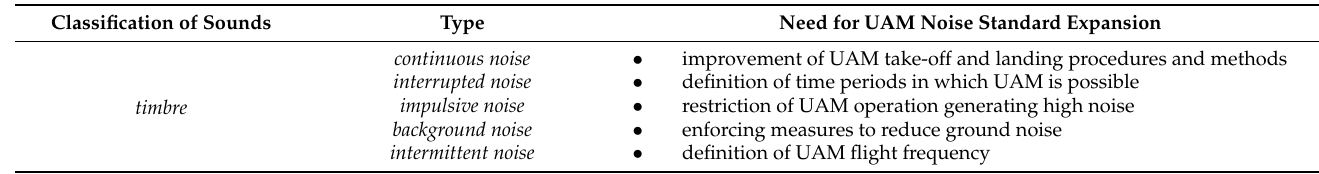
Table 7. Expansion of UAM noise standards considering timbre.